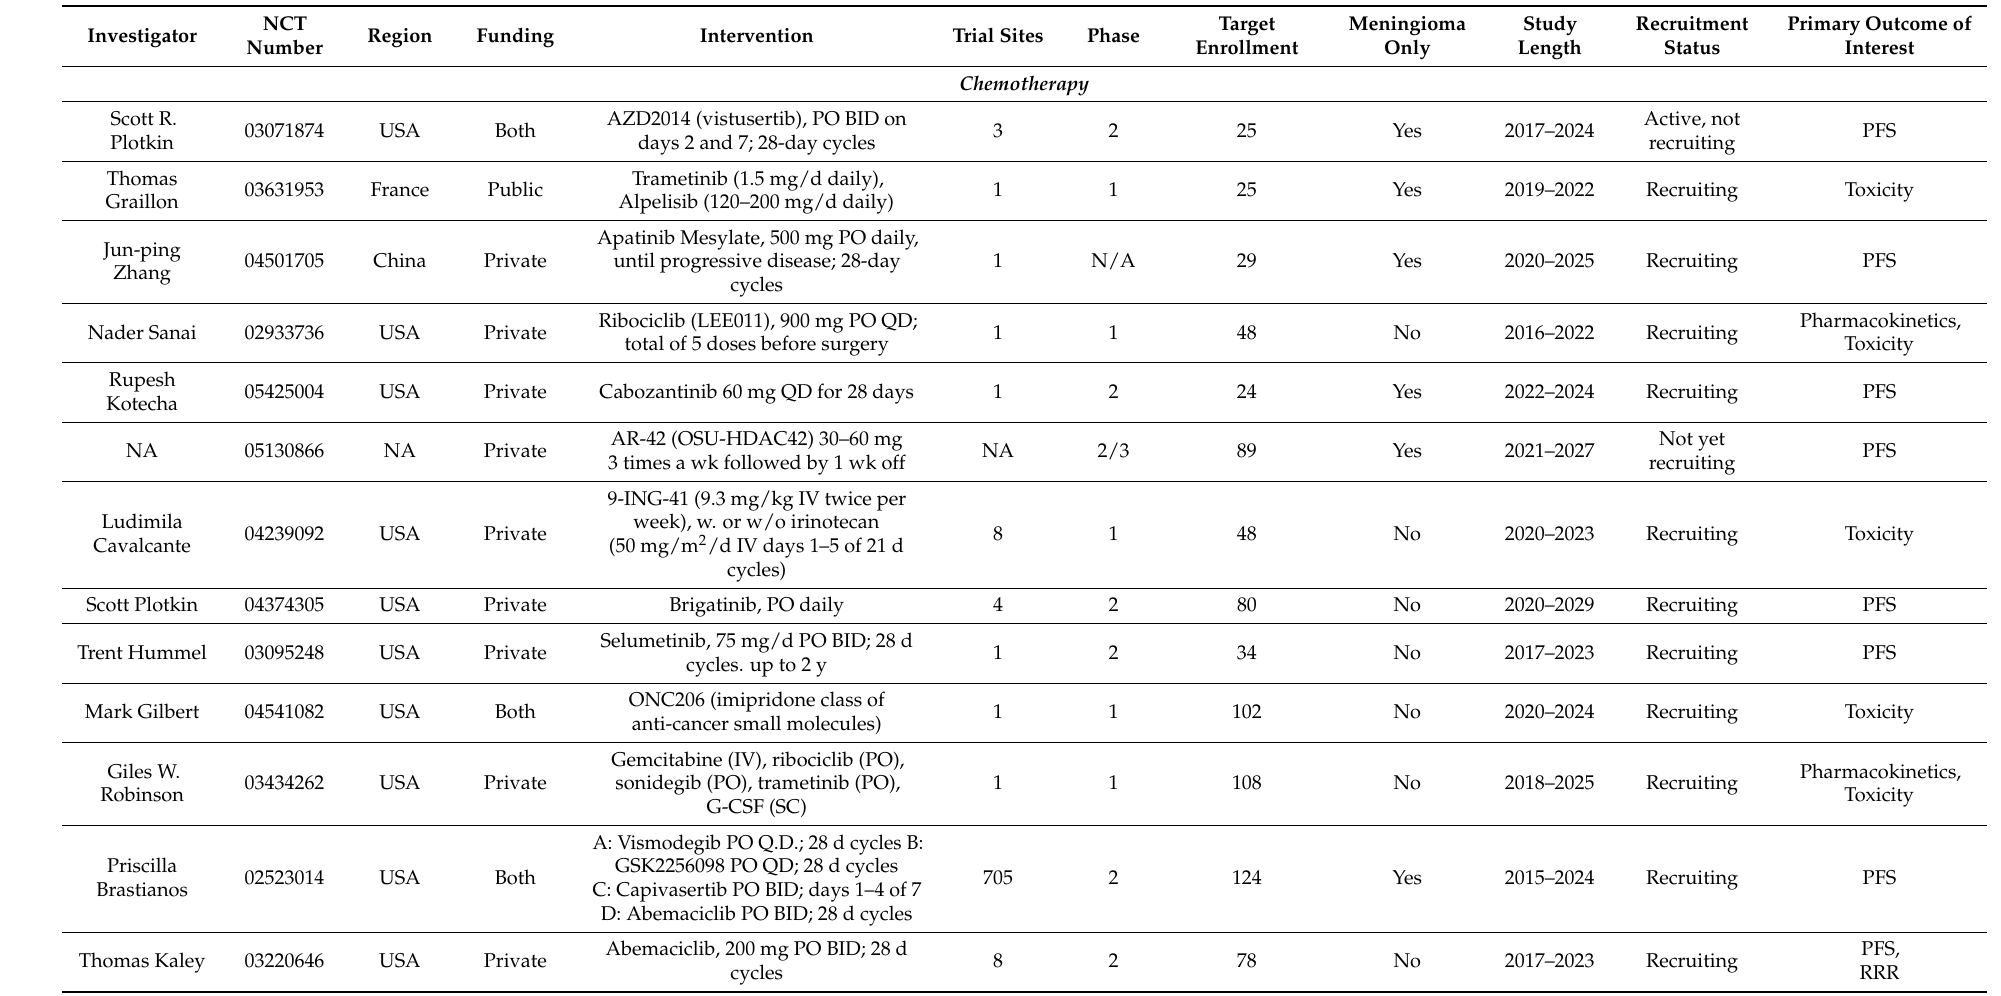
Table 3. Characteristics of ongoing pharmacotherapy clinical